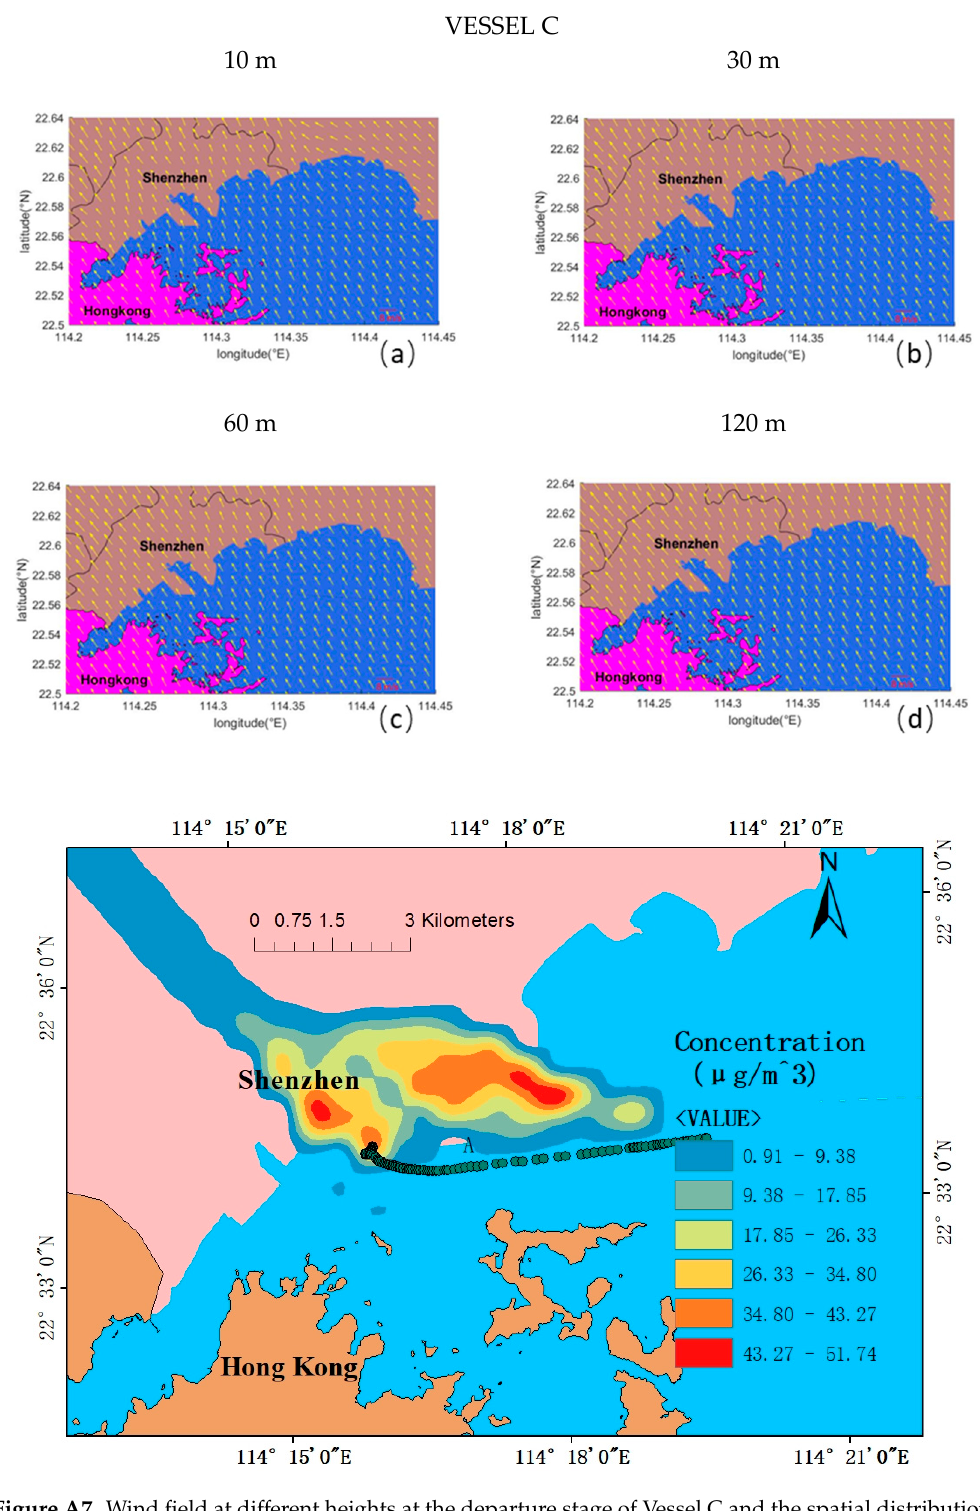
Figure A7. Wind field at different heights at the departure stage of Vessel C and the spatial distribution of the maximum concentration of each simulation grid during the simulation period. ( a ) 10m, ( b ) 30m, ( c ) 60m and ( d ) 120m.